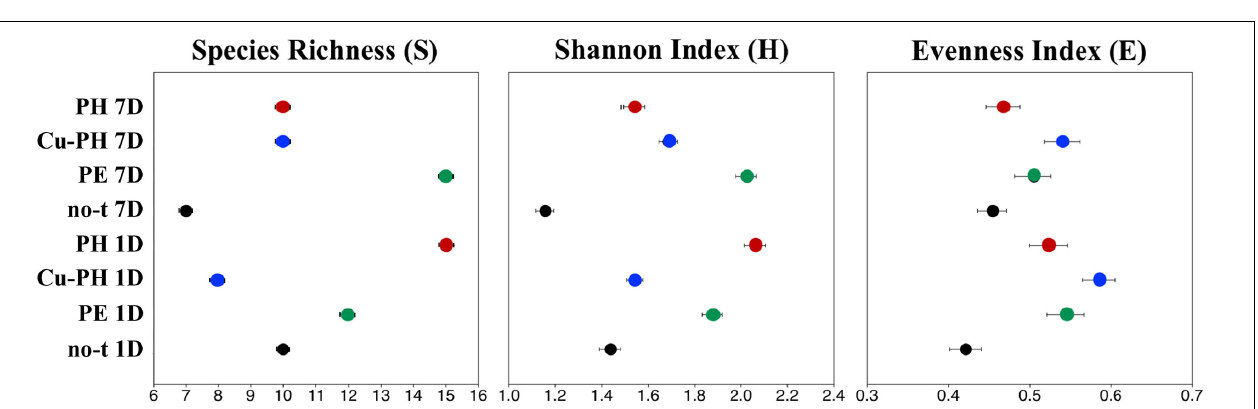
FIGURE 3 | Values for ecological diversity indices of total richness (S), Shannon–Weaver diversity (H), and evenness (E) obtained by using combined Ssp I and Avr II T-RFLP data of samples collected 1 or 7 days after the last treatment.